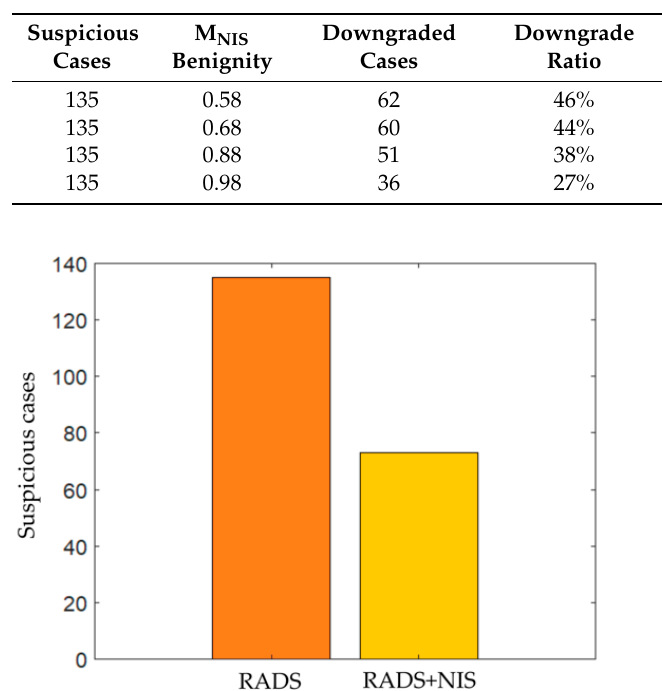
Figure 9. Examples of difficult cases that misclassified by readers. ( a ) Axial CT images of biopsy proven three pulmonary adenocarcinomas that were misclassified by both readers and correctly classified by machine (NIS classifier). ( b ) Three pulmonary granulomas that were misclassified by both readers and correctly classified by machine. ( c ) Three pulmonary adenocarcinomas that were misclassified by both human and machine. Table 2. The effect of M NIS benignity threshold on downgrading cases that were initially deemed as suspicious by lung-RADS alone.